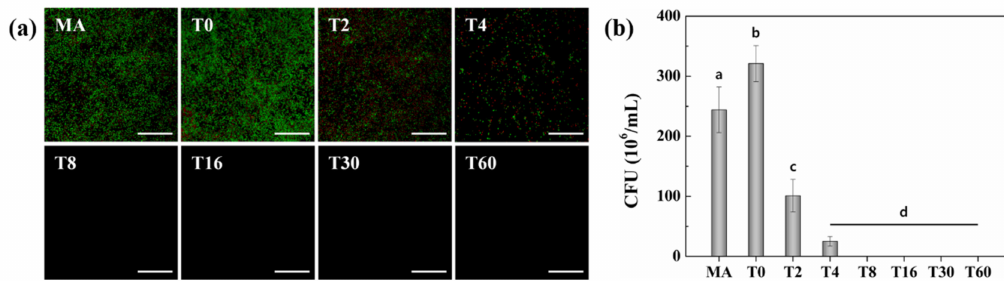
Figure 3. ( a ) Fluorescence images of live (green) and dead (red) stained S. aureus on specimens following 24 h of incubation (scale bar = 200 µ m). ( b ) Antibacterial activity of specimens versus adherent S. aureus seeded after 24 h assessed using the CFU count method (di ff erent letters indicate significantly di ff erent groups at p <